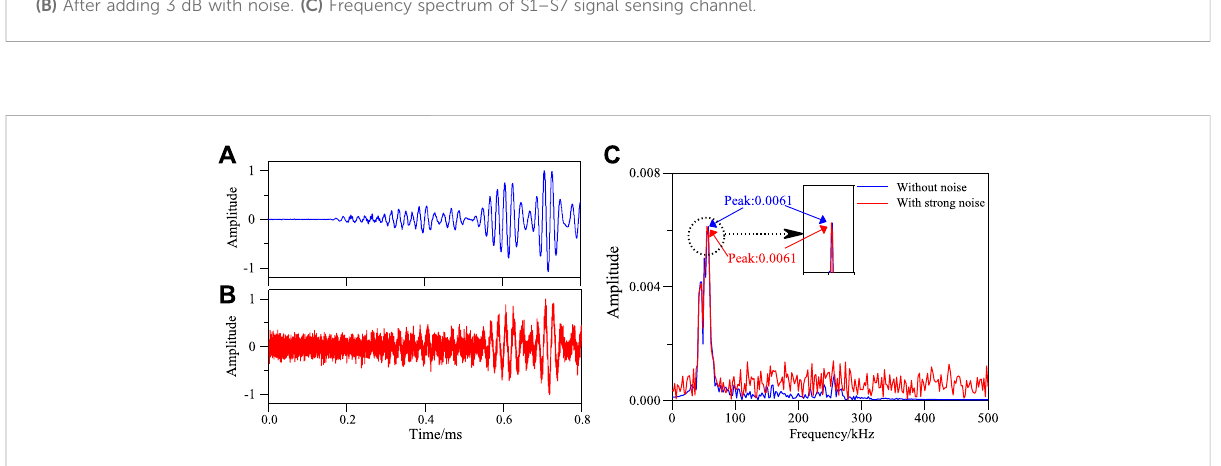
FIGURE 24 Frequency spectrum of S1 – S7 sensing channel without damage in structure under strong noise environment. (A) Effective signal-undamaged. (B) After adding 3 dB with noise. (C) Frequency spectrum of S1 – S7 signal sensing channel.